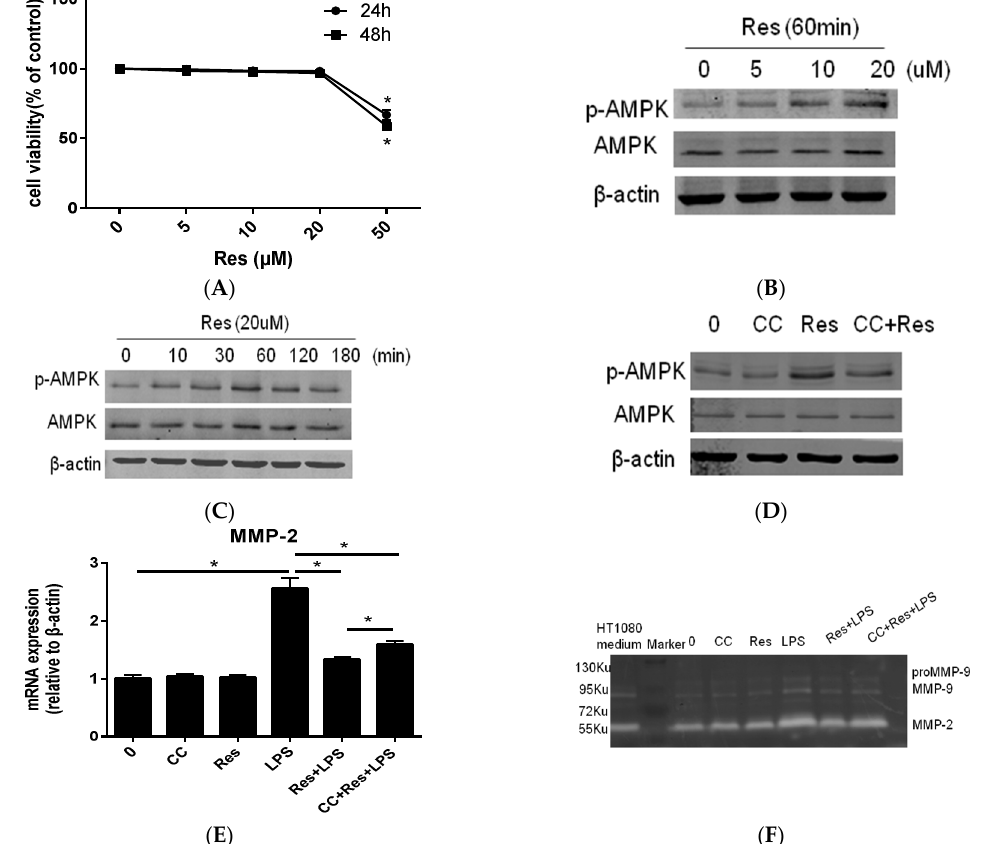
Figure 2. The involvement of AMPK in the inhibitory effects of resveratrol on MMP-2 expression in MC3T3-E1 cells stimulated by P. endodontalis LPS. ( A ) MC3T3-E1 cells were incubated with 0, 5, 10, 20, 50 µM resveratrol (Res) for 24 and 48 h, after which MC3T3-E1 cells viability was determined by MTT analysis. MC3T3-E1 cells were incubated with various concentrations resveratrol for 60 min ( B ); MC3T3-E1 cells were treated with 20 µM resveratrol for the indicated time ( C ); MC3T3-E1 cells were pretreated with 20 µM resveratrol for 1 h, or not, in the absence or presence of 10 µM Compound C (CC) for 30 min ( D ). Treated MC3T3-E1 cell lysates were subjected to western blot analysis using antibodies against total AMPK and AMPK phosphorylated at Thr172 on the α-subunit (shown as p-AMPK). MC3T3-E1 cells were pretreated with 20 µM resveratrol for 1 h, or not, in the absence or presence of 10 µM Compound C for 30 min and then exposed to 10 mg L −1 P. endodontalis LPS for 24 h. MMP-2 mRNA expression was detected by real-time PCR ( E ) and the cell culture medium was then harvested to determine the collagenase activity of MMP-2 by gelatin zymography ( F ). HT1080 medium indicates conditioned medium collected from HT1080 cells (human fibrosarcoma cells) that served as a positive control. U is the atomic mass unit. 1 Ku is approximately equal to 1 KDa. * p < 0.05, as compared to the control group.